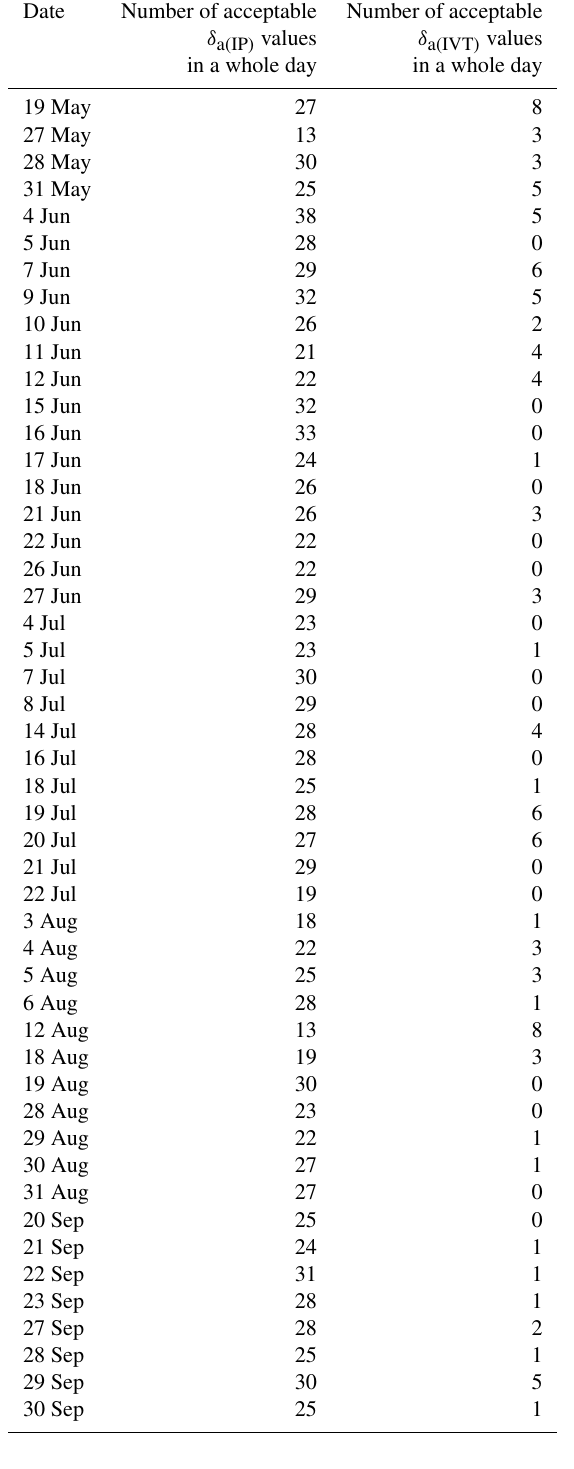
Table 1. The number of the estimated isotope composition of am- bient vapor meeting the criteria using the intersection point method ( δ a(IP) ) and the intermediate value theorem method ( δ a(IVT) ) among all 49d.